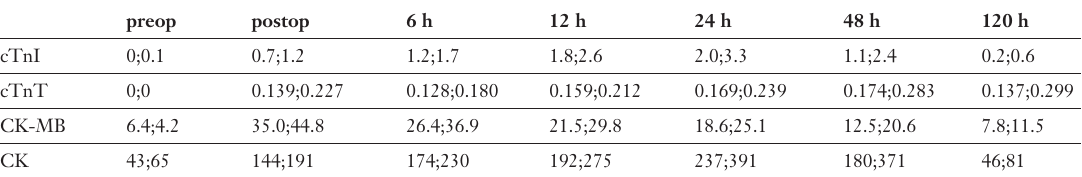
Figure 2 Postoperative me- dian time courses of CK-MB-activity and CK-activity. Vertical lines indicate 25%- quartile (Q1, inferior end of the line) and 75%-quartile (Q3, upper end of the line) of the